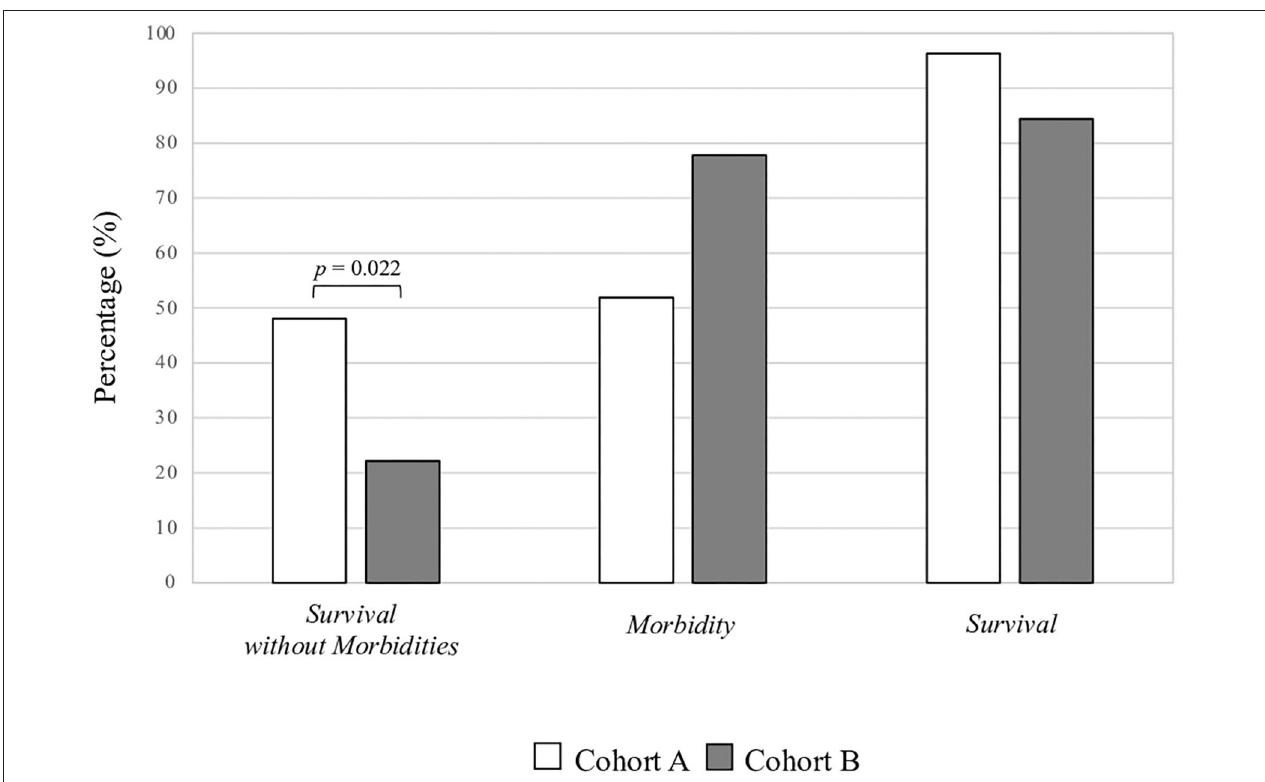
FIGURE 1 | Percentage of morbidity and survival in the two study Cohorts.